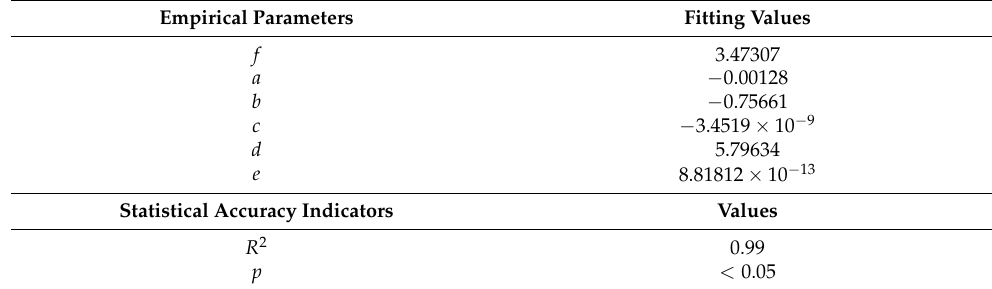
Table 5. Quantitative values of empirical parameters to predict Nu from Ha and Da numbers at (cid:101) = 0.4, θ = 45, and Ra = 10 5